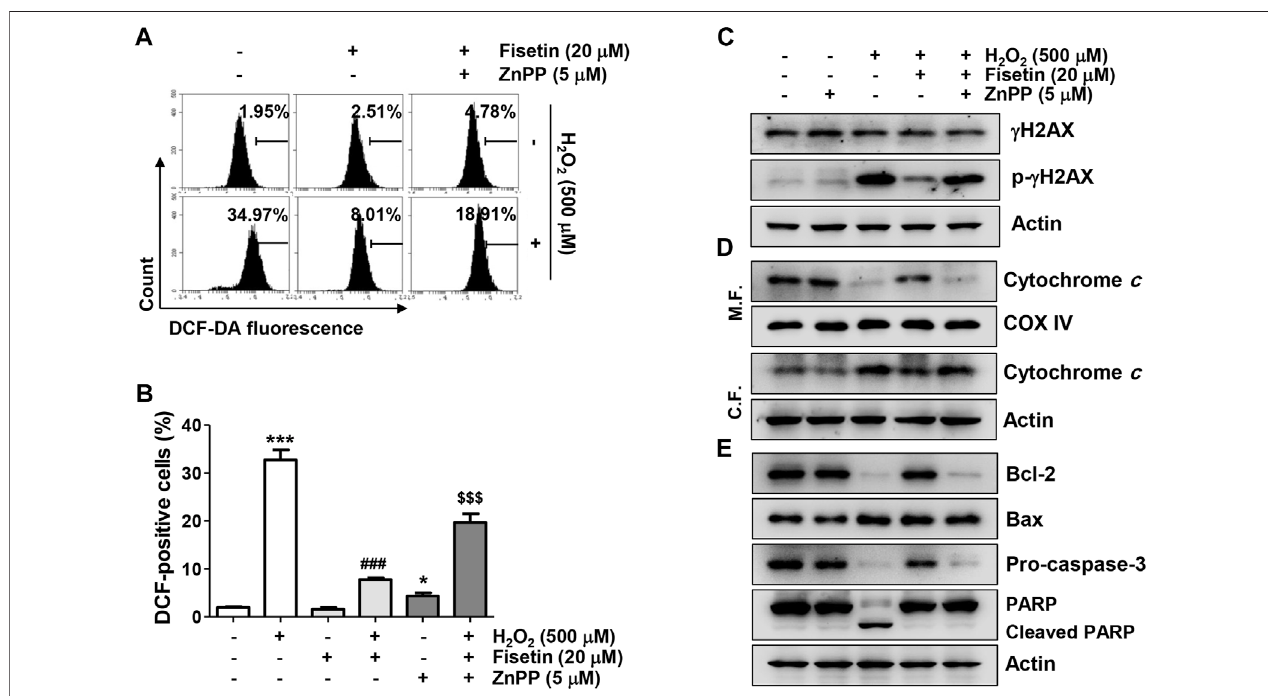
FIGURE 6 | The antioxidative activity and the inhibitory effect on the expression of apoptosis-related factors of fi setin were disappeared in the presence of ZnPP in H 2 O 2 -treatedARPE-19cells.Cellsexposedto20 μ M fi setinand/or5 μ MZnPPfor1 hwerefurthertreatedwith500 μ MH 2 O 2 for1 h (A,B) or24 h (C,D) . (A,B) Thelevels ofROSgenerationweredetermined usingDCF-DAdye. (A) Representativeresultsfrom fl owcytometryanalyses arepresented. (B) Thegraphrepresents themeanwith SD ( n = 4, * p ˂ 0.05 and *** p ˂ 0.001 compared with control group; ### p ˂ 0.001 compared with H 2 O 2 treatment group; $$$ p ˂ 0.001 compared with fi setin + H 2 O 2 treatmentgroup). Suppression ofDCF-positive cellsin thecellsco-treated with fi setinand H 2 O 2 wassigni fi cantlyrestored inthe presence ofHO-1 inhibitor ZnPP. (C – E) The expression change ofthe indicated protein wascon fi rmed using the extracted whole protein or mitochondrial and cytoplasmic proteins. The down-regulation of the expression of pro-apoptotic Bax, cleaved PARP, cytosolic cytochrome c, and p- γ H2AX in the cells co-treated with fi setin and H 2 O 2 was signi fi cantly restored by ZnPP.